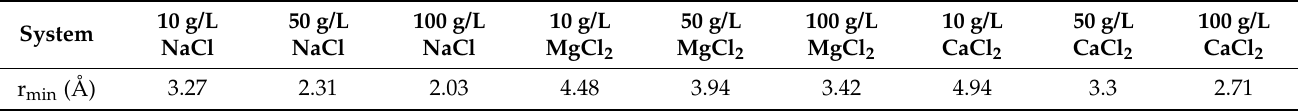
Table 2. Minimum distance of cation from head groups in different